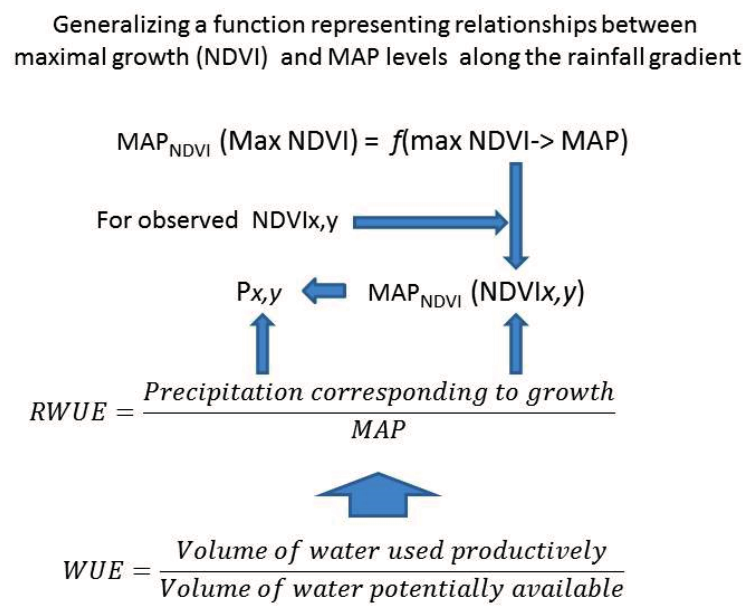
Figure 2. The development of the concept of Relative Water Use Efficiency